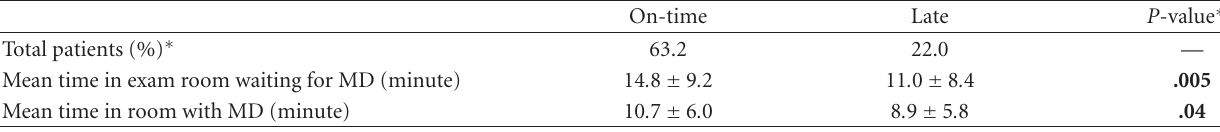
Table 3: Patient wait times by on time versus late arrival patients.